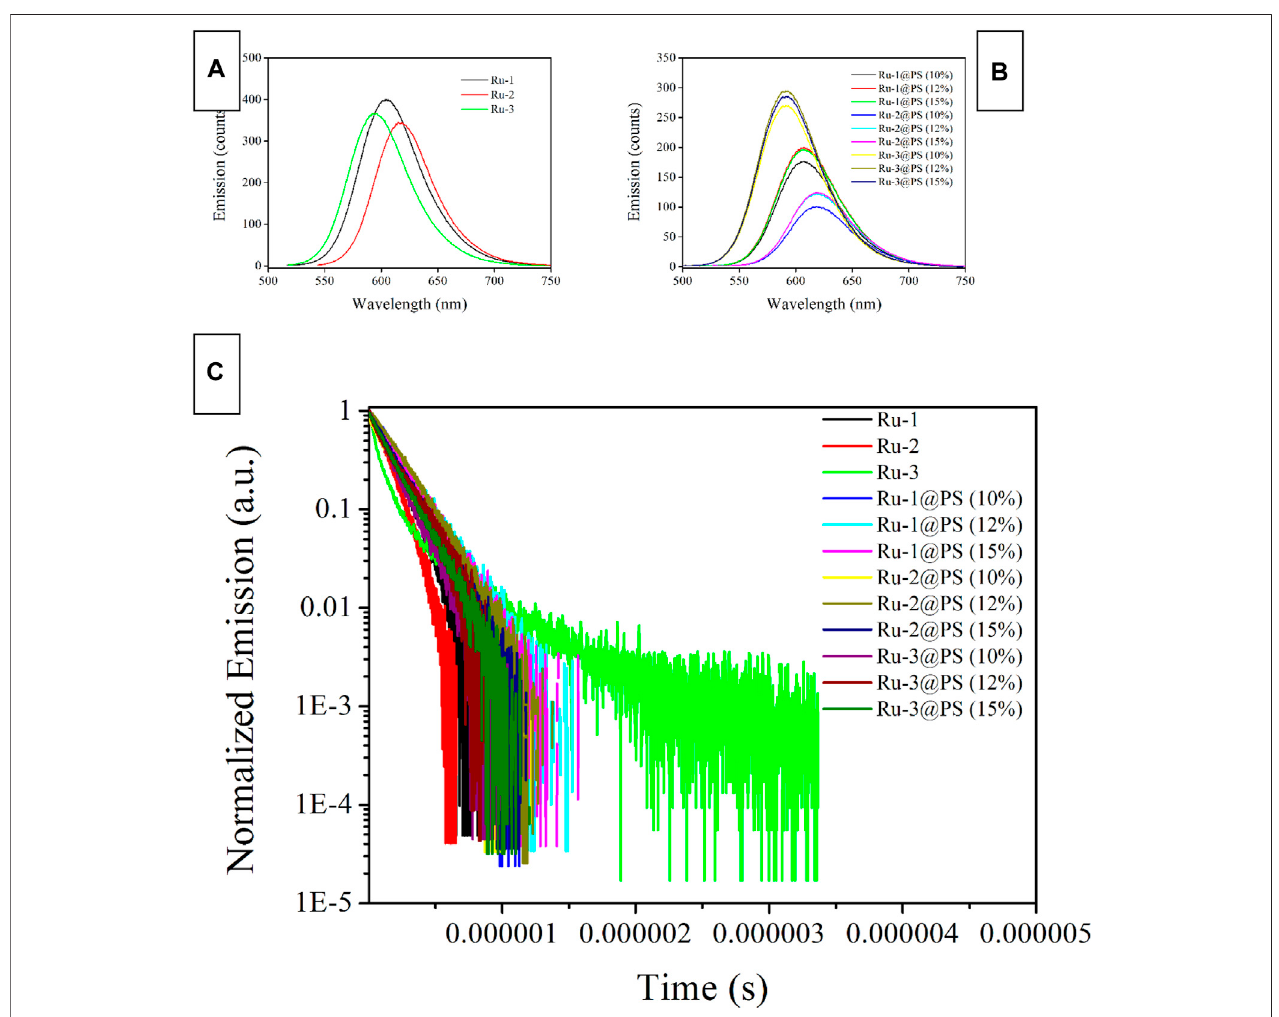
FIGURE 5 | Emission spectra (A, B) and emission decay dynamics (C) of Ru-n complexes and Ru-n@PS fi bers in the solid